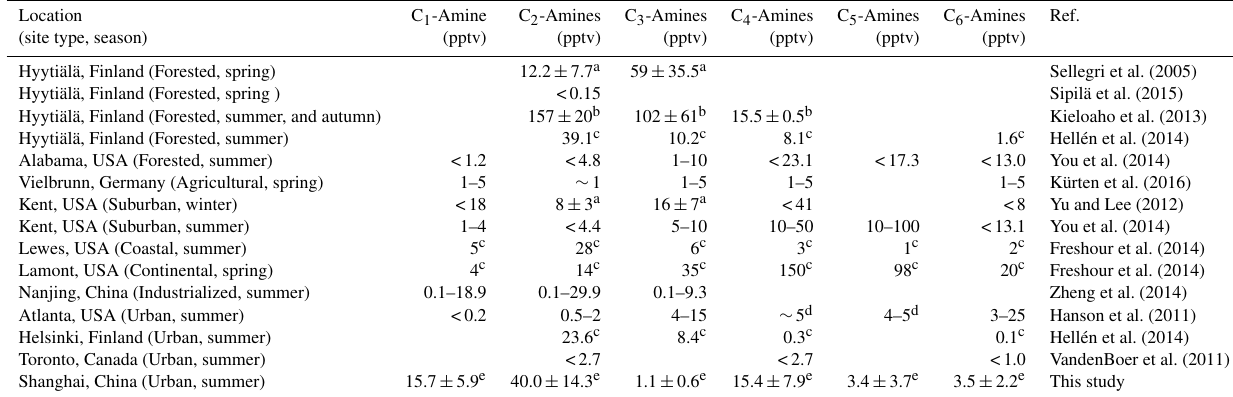
Table 2. Inter-comparison of gaseous amines measured in different locations with different surroundings. Location